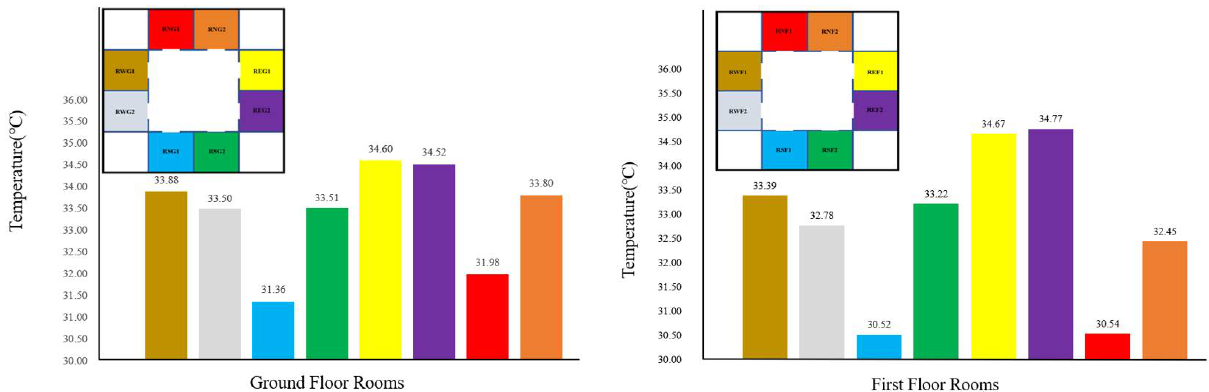
Figure 17. Average air temperature (°C) in each room for the baseline courtyard model with four small trees.